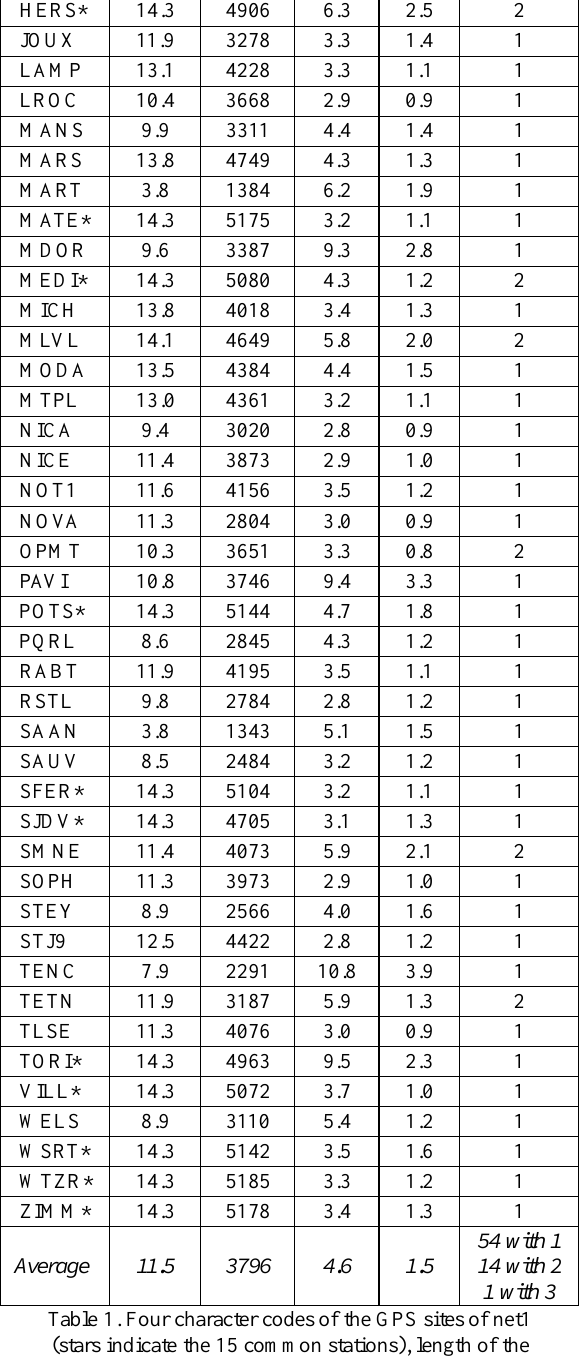
Table 1. Four character codes of the GPS sites of net1